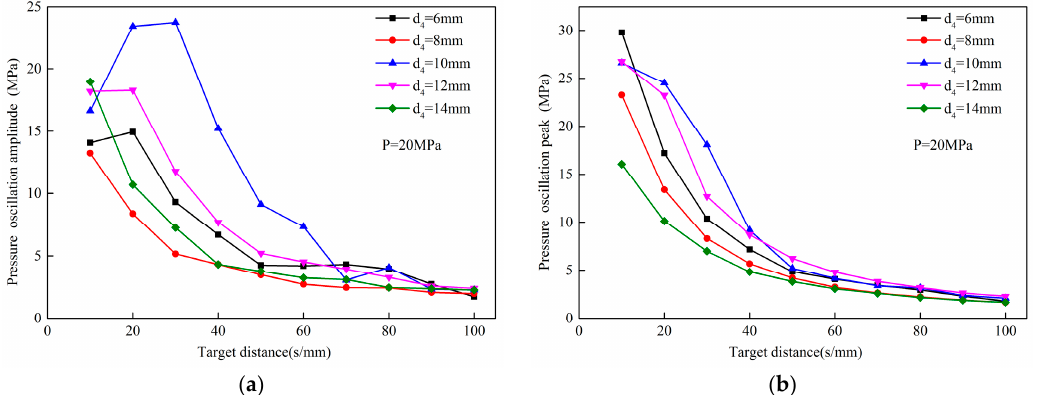
Figure 14. Effect of d 4 on nozzle performance at 20 MPa pressure. ( a ). c urves of nozzles with different Figure 14. E ff ect of d 4 on nozzle performance at 20 MPa pressure. ( a ). curves of nozzles with di ff erent d 4 on pressure pulsation amplitude at different target distances. ( b ). c urves of nozzles with different d 4 on pressure pulsation amplitude at di ff erent target distances. ( b ). curves of nozzles with di ff erent d 4 d 4 on pressure oscillation peak at different target distances. on pressure oscillation peak at di ff erent target